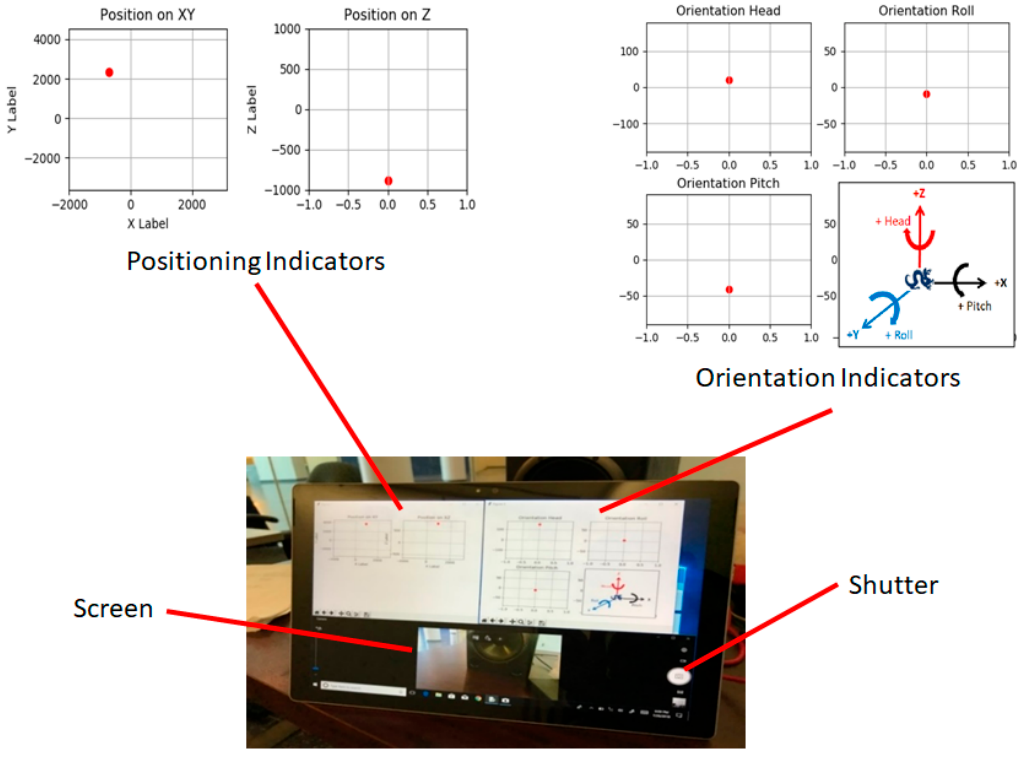
Figure 11. User interface prototype.